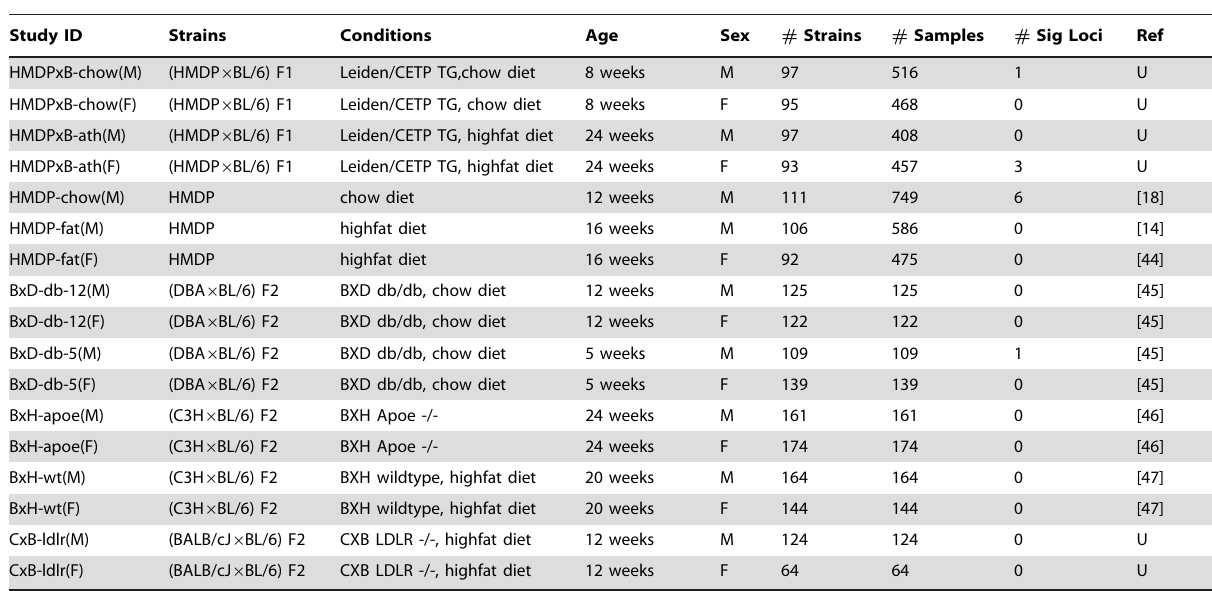
Table 1. 17 HDL studies for meta